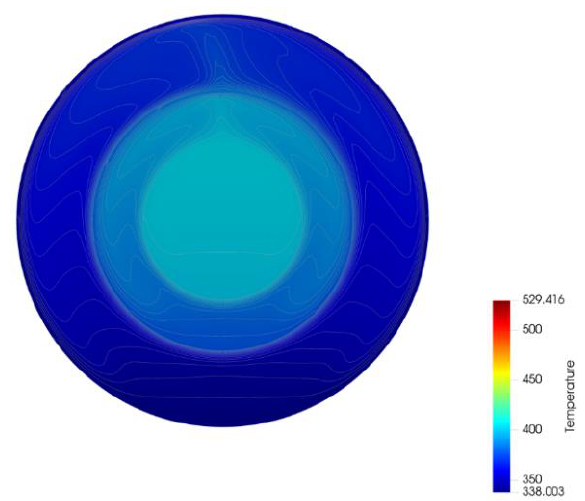
Fig. 4. Temperature field after 30 minutes .